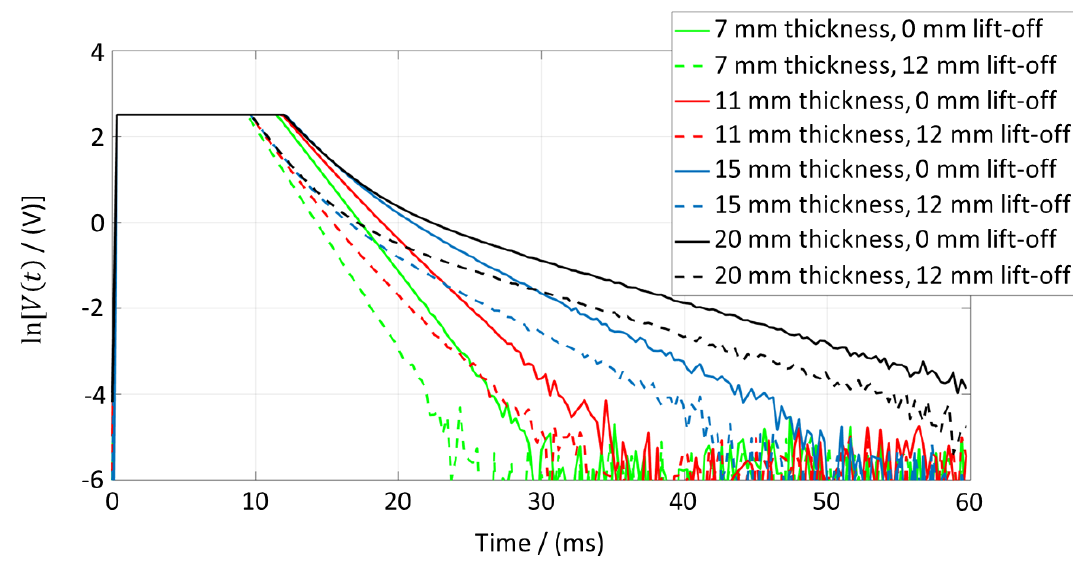
Figure 4. Experimentally captured PEC signals used for the work of this paper in logarithmic scale.